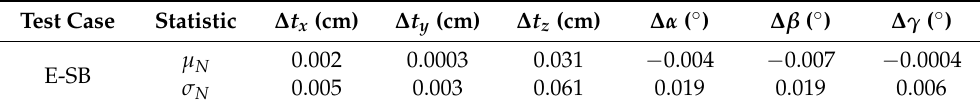
Table 17. Mean and standard deviation of the pose estimation errors for test case E-SB.